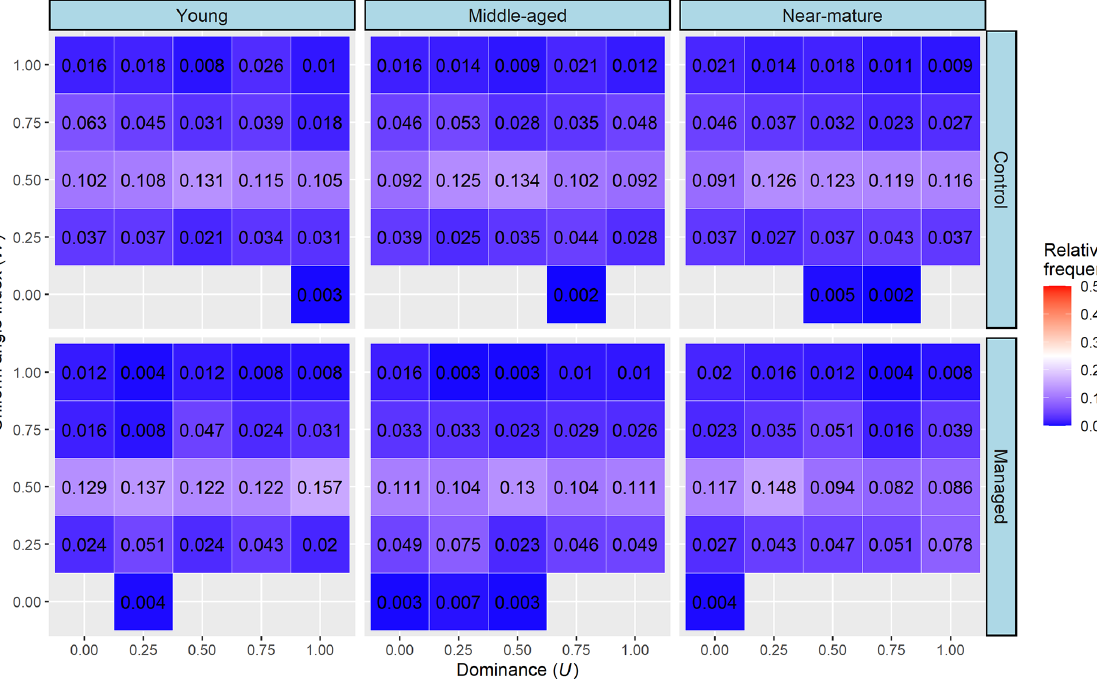
Figure 5. Bivariate distribution of U and W at different tree